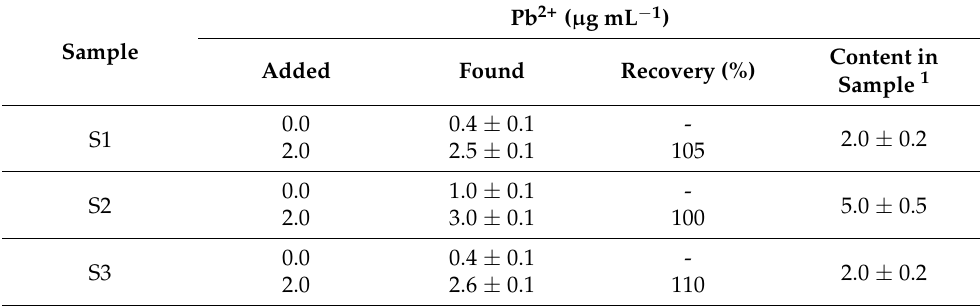
Table 2. Lead content in samples of aqueous sulfuric acid solutions contained in acid batteries.